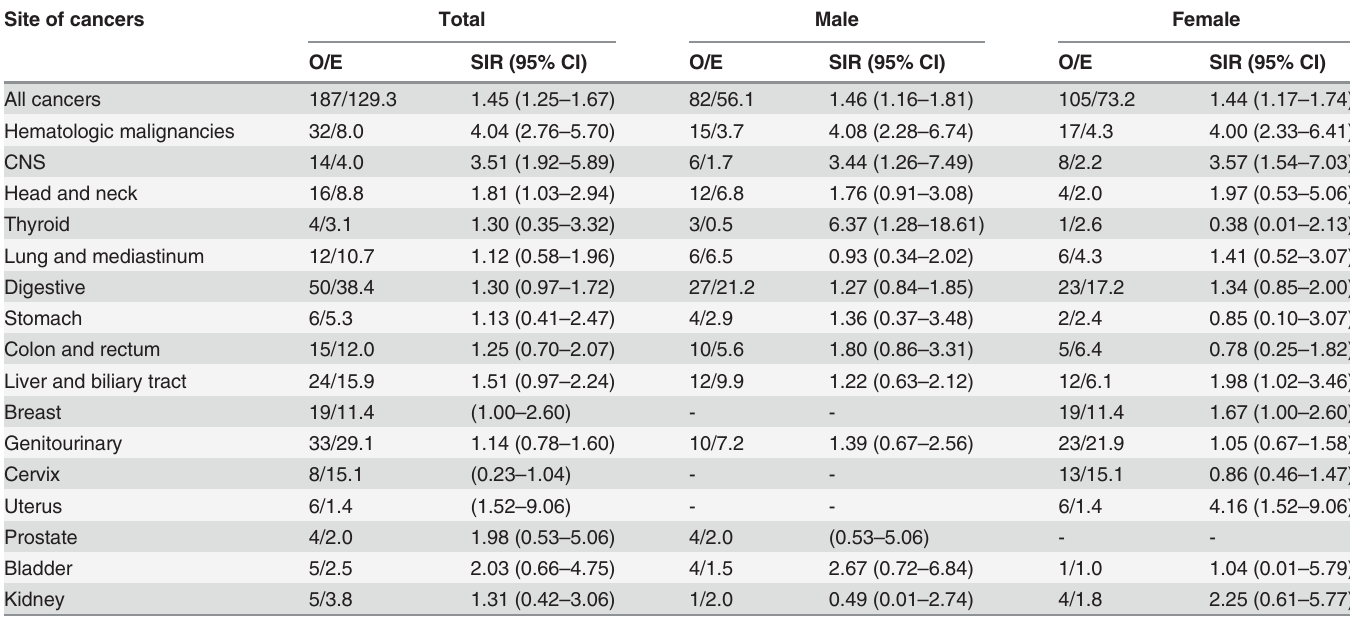
Table 4. Standardized incidence ratios (SIRs) for all and speci fi c cancer types among patients with